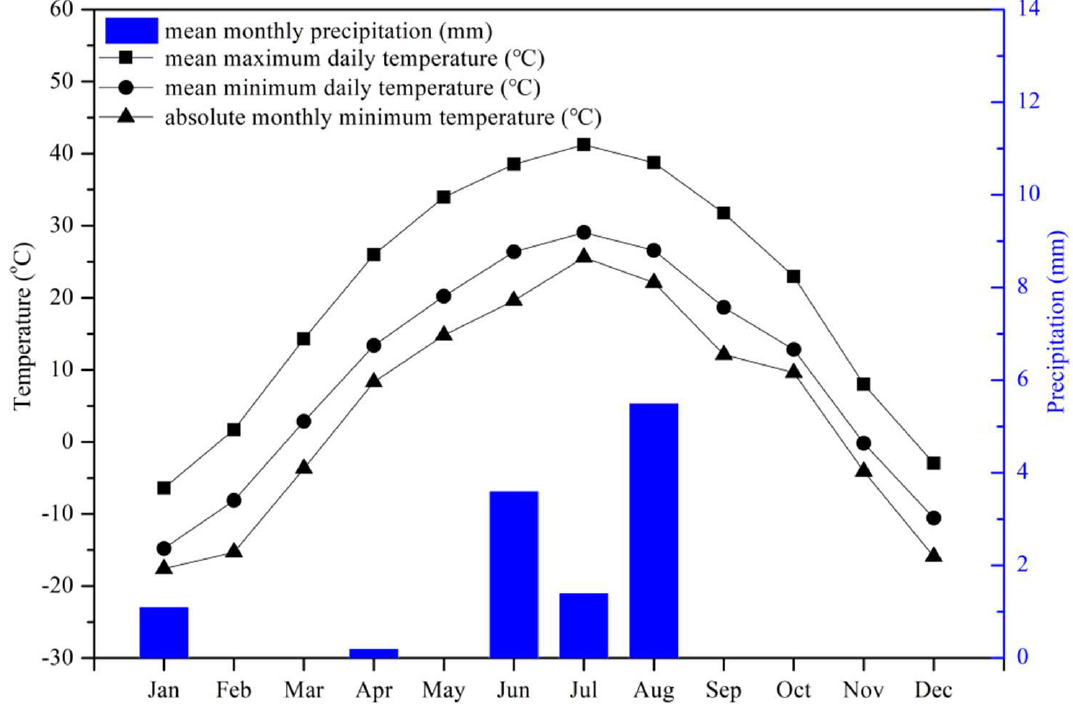
Figure 2. Climate diagram of the study area (based on data from Arghan for the period from 2013 to 2015).